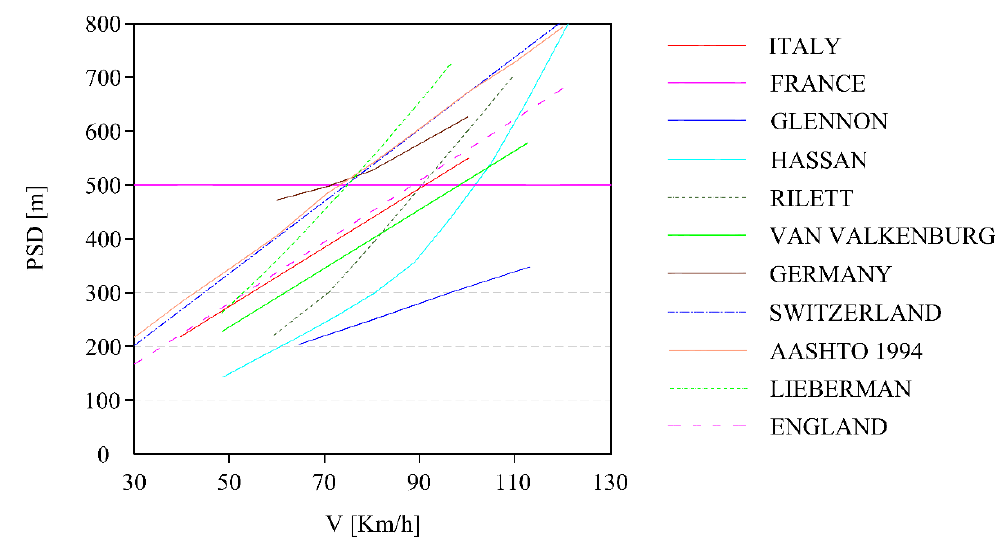
Figure 2. Passing sight distance (PSD) models comparison. Table 2. Passing sight distance (PSD) models.